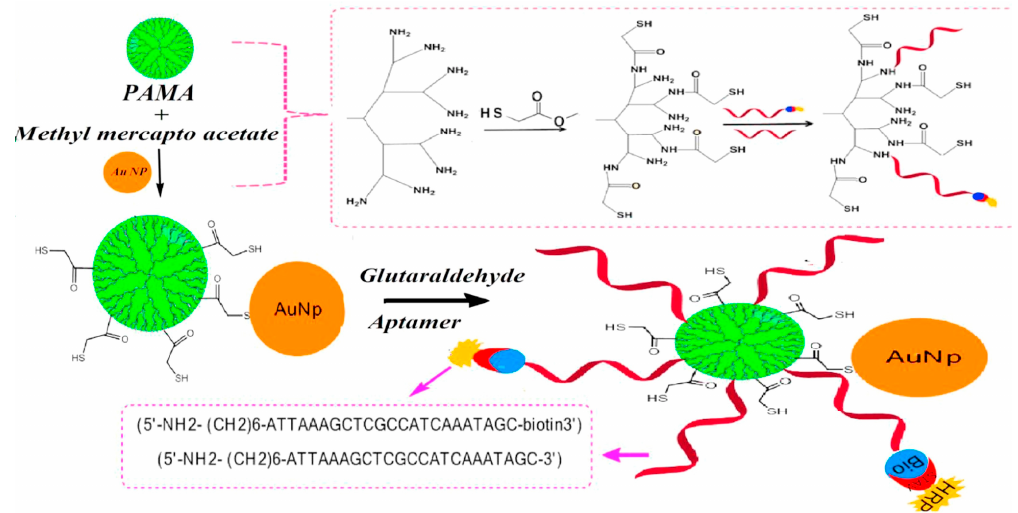
Figure 3. Illustration of the stepwise process for PSA immunosensor fabrication. Reproduced with permission from [70].